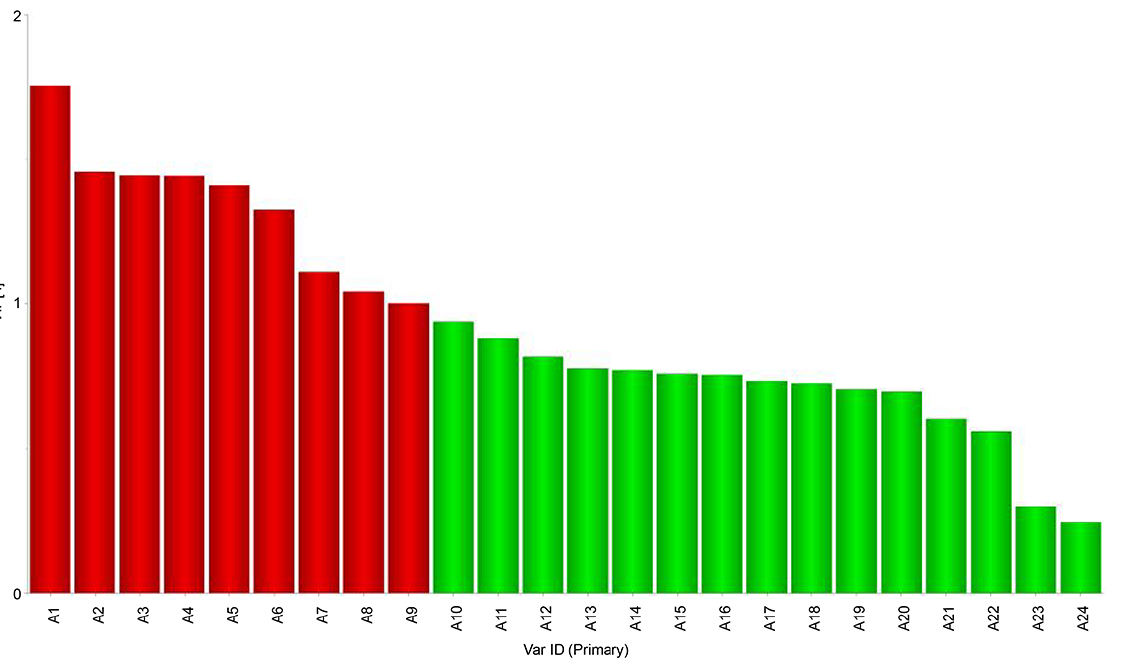
Figure 7. Analysis of the microbiota and volatile compounds using a VIP plot of bacteria and volatile